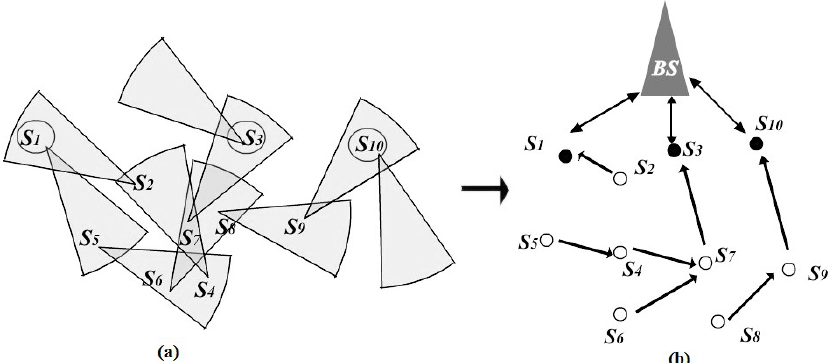
Figure 4. ( a ) An example of FSOSN; ( b ) Virtual topology after running the simple-link